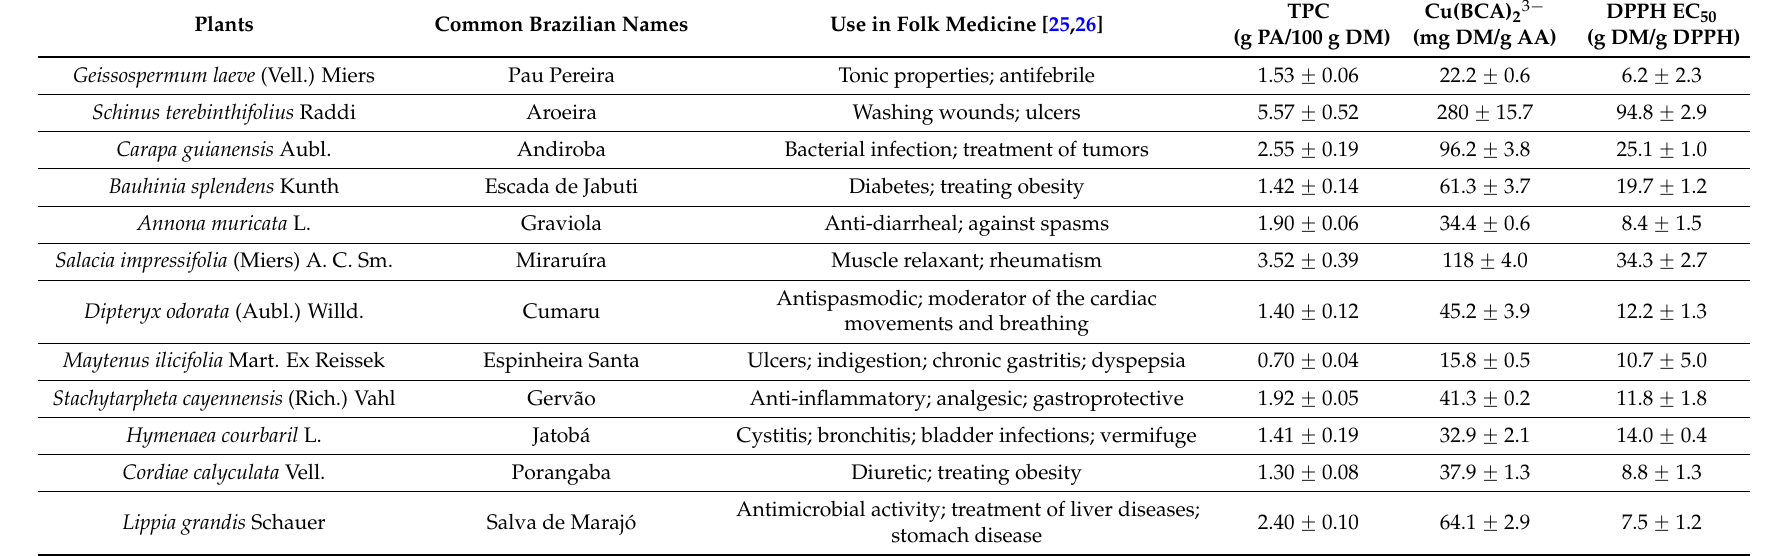
Table 2. Reducing capacity and total polyphenol content of some Brazilian medicinal